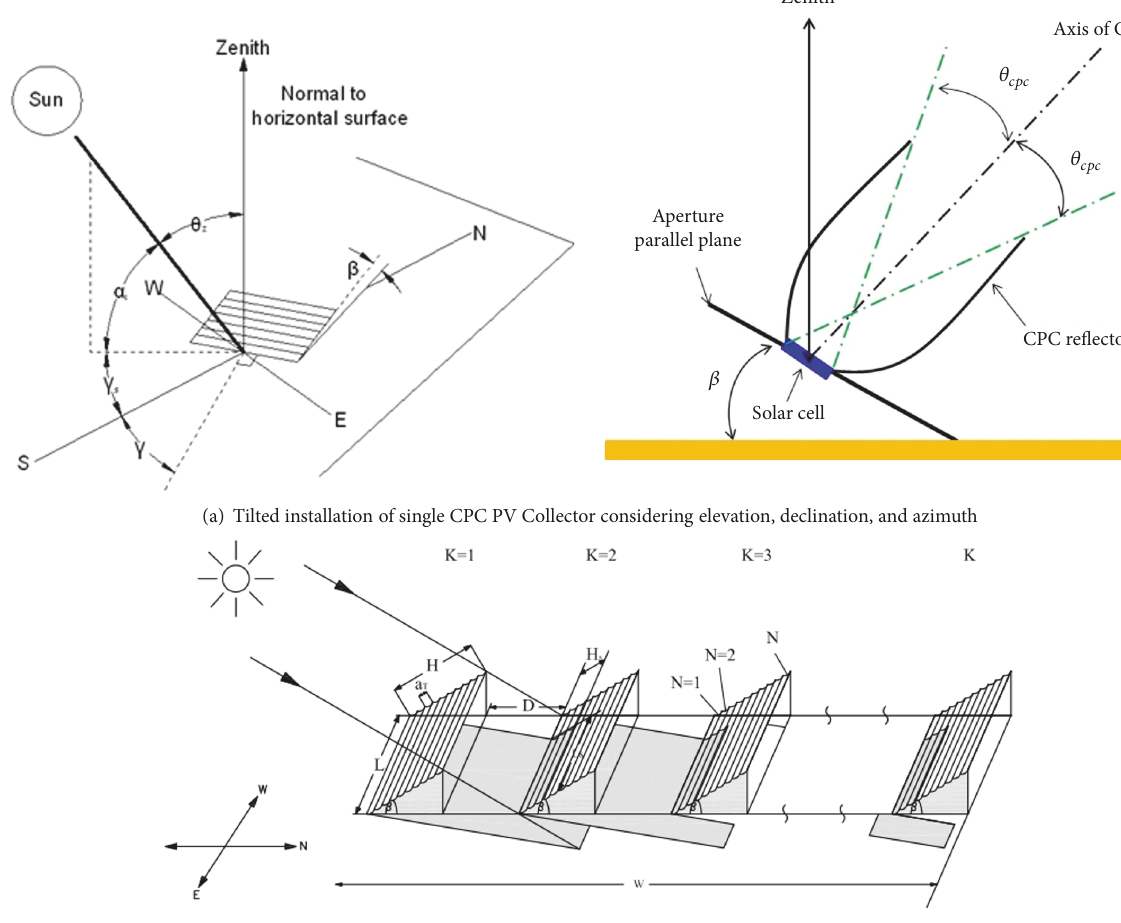
Figure 3: Design process for maximization of a solar CPC PV collector